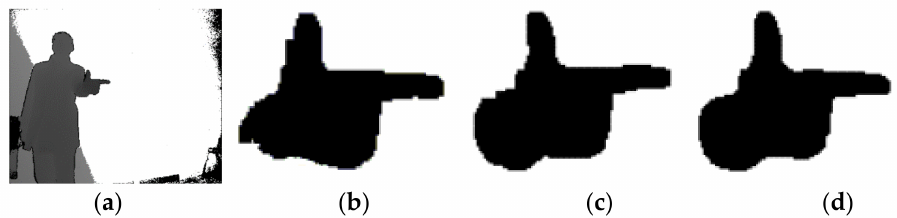
Figure 2. Different effects of the good and bad threshold values in segmentation: ( a ) gives the depth image while ( b – d ) show different segmentation results using different threshold